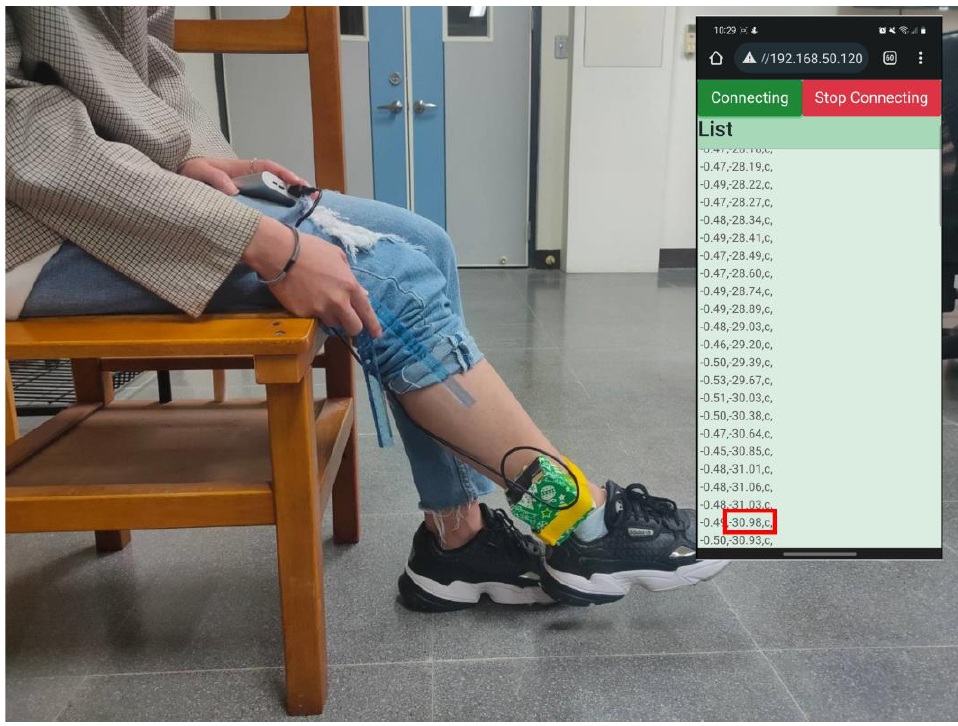
Figure 10. Angle detection of CPGAFDWD in Android.